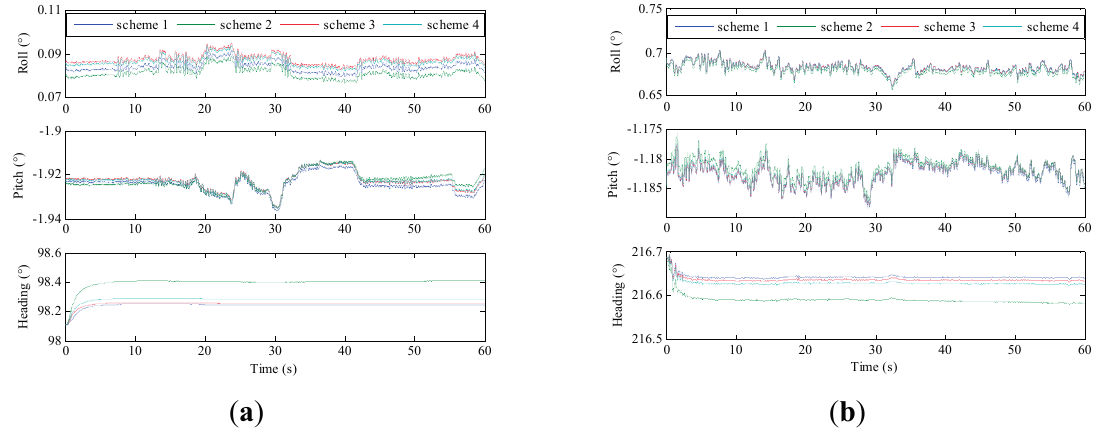
Figure 11. The fine alignment process results: ( a ) tactical grade IMU; ( b ) navigation grade